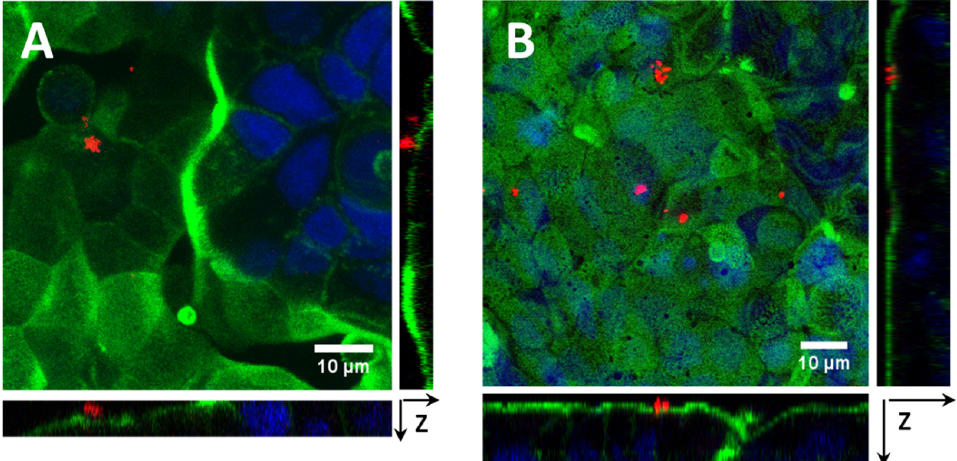
Figure 11. CLSM images of confluent intestinal barriers after 24 h of exposure to M41-RhB-L ( A ) and M41-Cin C6 -L ( B ). Actin microfilaments (stained with Alexa Fluor Phalloidin)) in green, cell nuclei (stained with Hoechst 33342) in blue, and M41-#-L particles in red (see Section 2.16 for details). Lateral boxes represent z-stack projections along x–z and y–z axis.